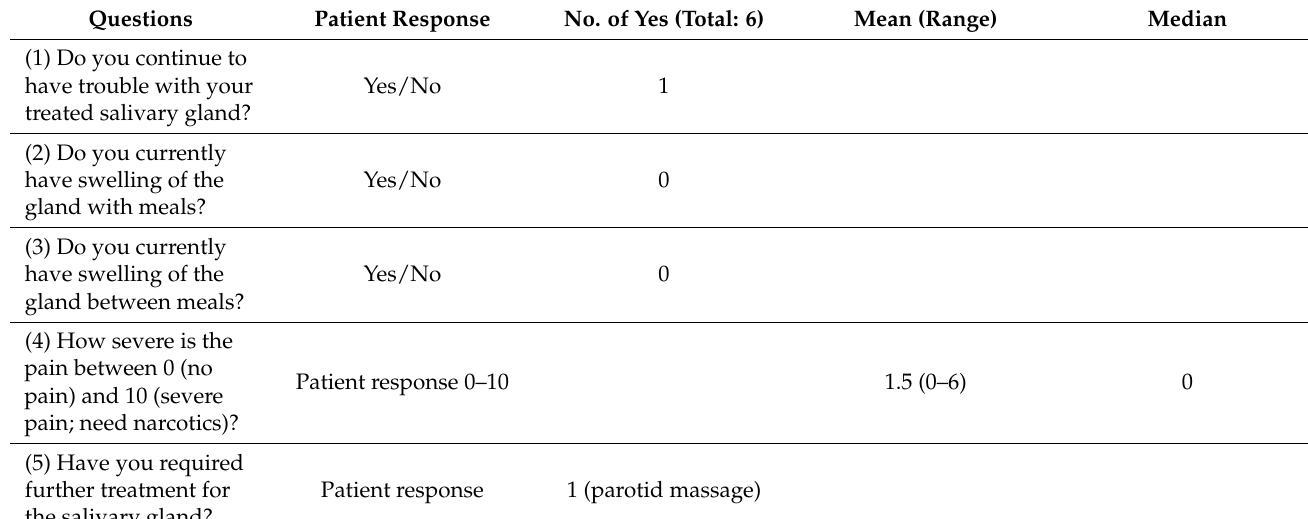
Table 2. Symptoms improvement evaluation according to Gillespie et al.